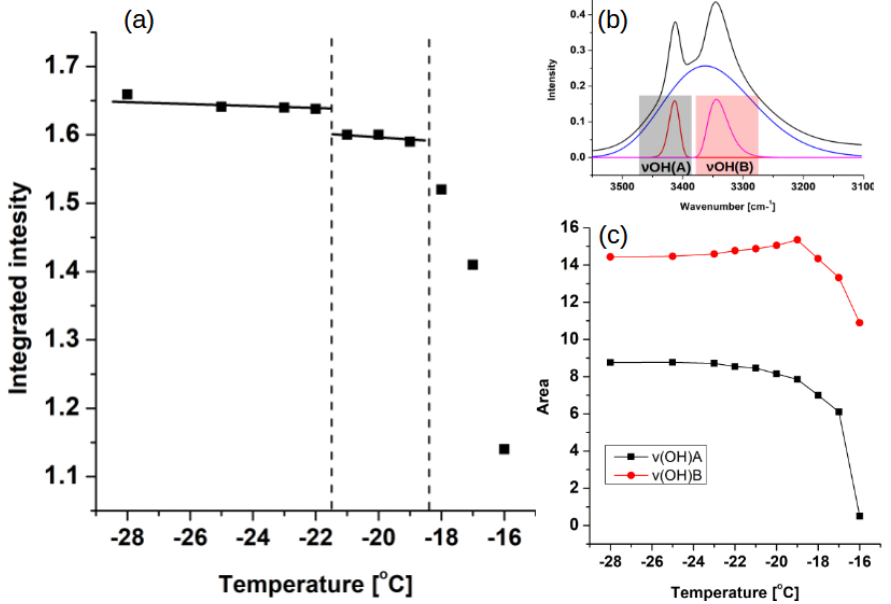
Figure 4. ( a ) Temperature evolution of integrated intensity of the CH 2 rocking vibrations region (750–710 cm − 1 ), ( b ) deconvolution of stretching OH ( ν OH) region and ( c ) temperature dependence of the area of deconvoluted ν OH